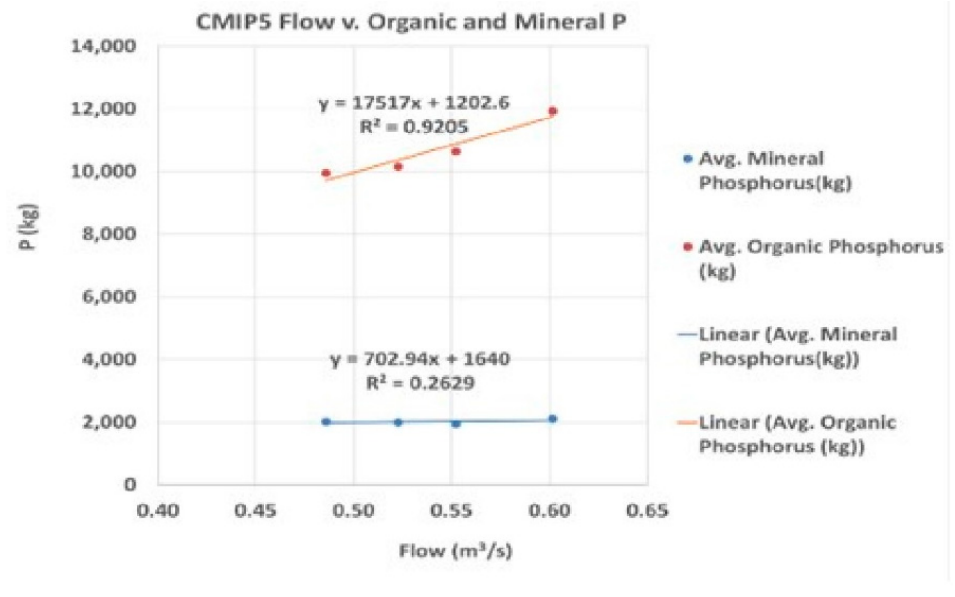
Figure 17. Average of 20 CMIP5 GCMs flow vs. organic and mineral phosphorus (2018– 2100).